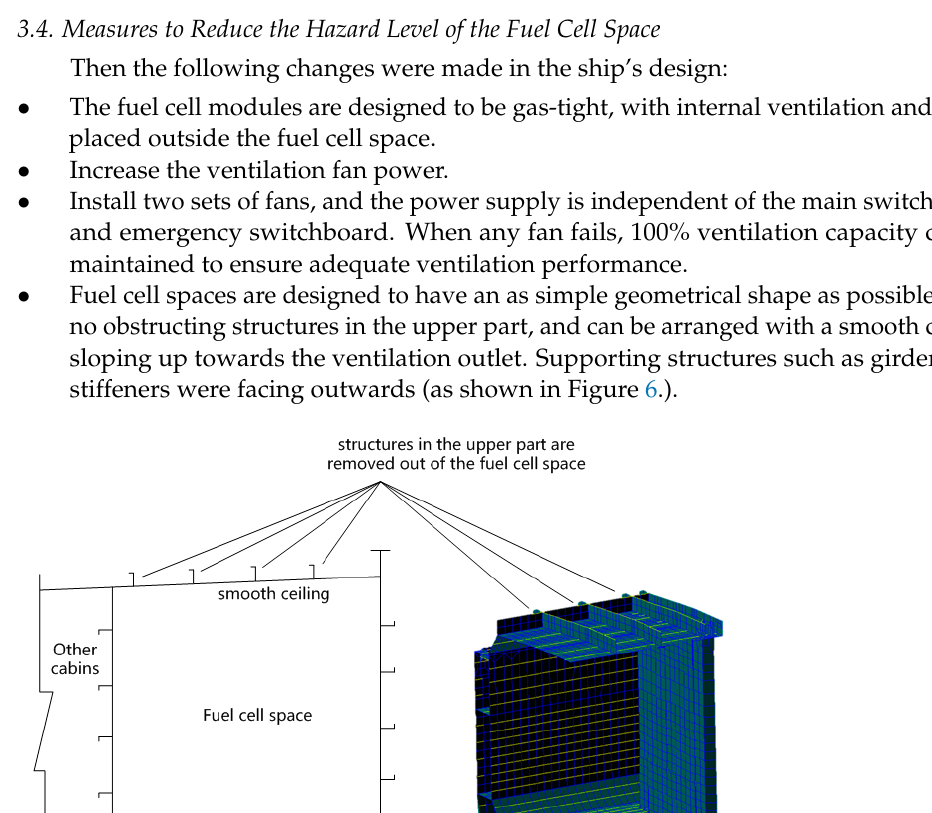
Figure 5. Zones for the grade of release and effectiveness of ventilation.